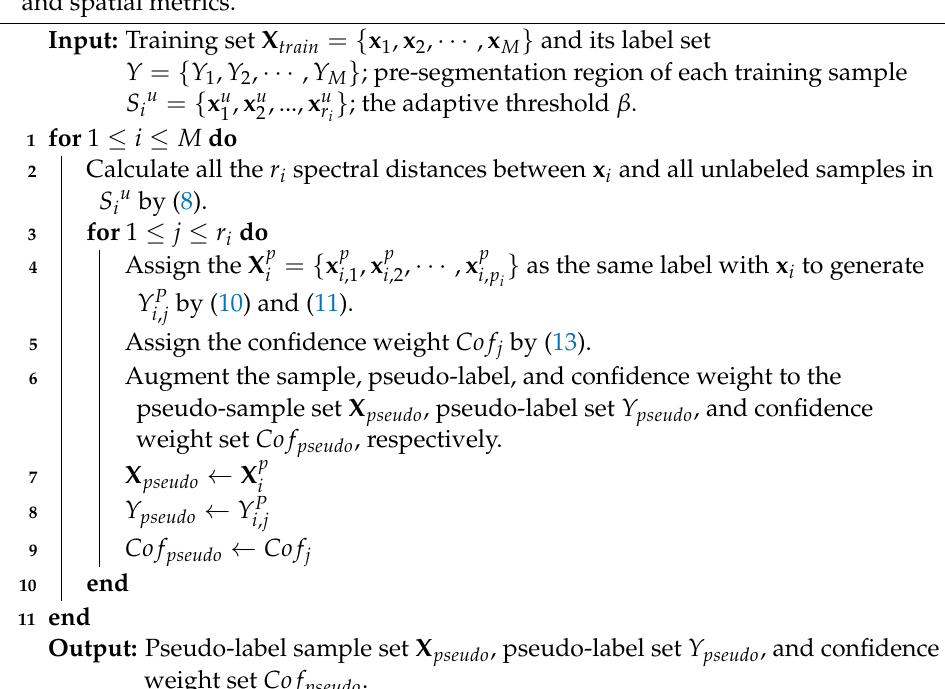
Algorithm 1: Label propagation based on pre-segmentation map with spectral and spatial metrics.